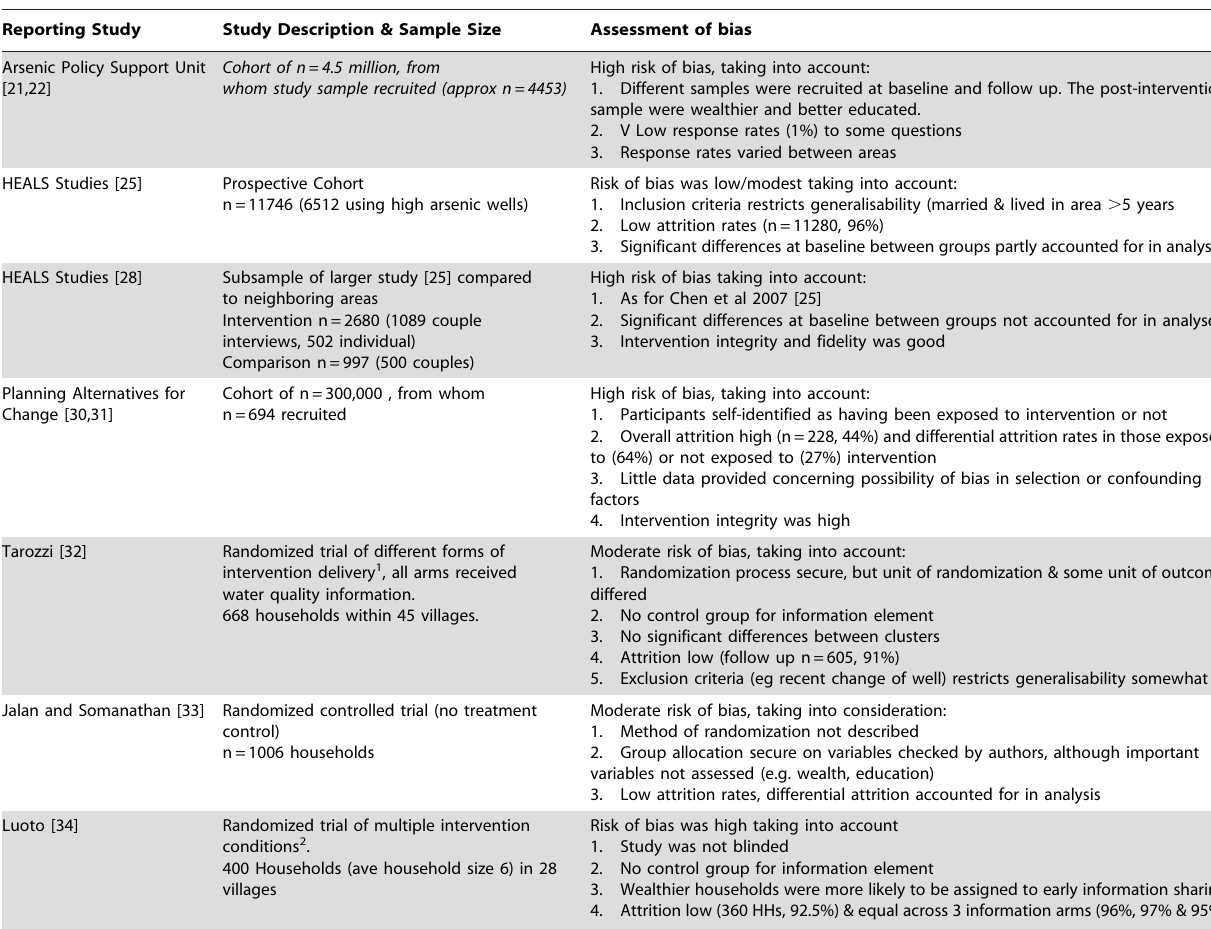
Table 2. Included Studies Assessment of